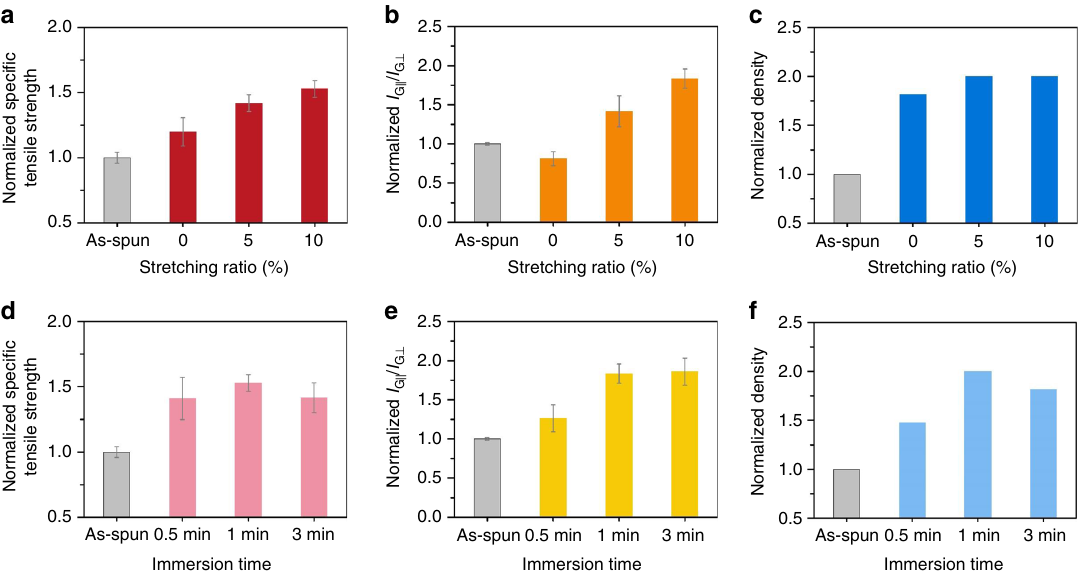
Fig. 3 Optimization of CSA densi fi cation process. Evolutions in a normalized speci fi c tensile strength, b normalized I G ∣∣ / I G ⊥ , and c normalized density of CNTFs having the medium I G / I D during CSA densi fi cation process with various stretching ratios (immersion time, 1 min). Evolutions in d normalized speci fi c tensile strength, e normalized alignment, and f normalized density of CNTFs with various immersion times (stretching ratio 10%). All values are normalized to those of as-spun CNTFs. Error bars represent the standard deviation. All real values are presented in Supplementary Fig. 4, including